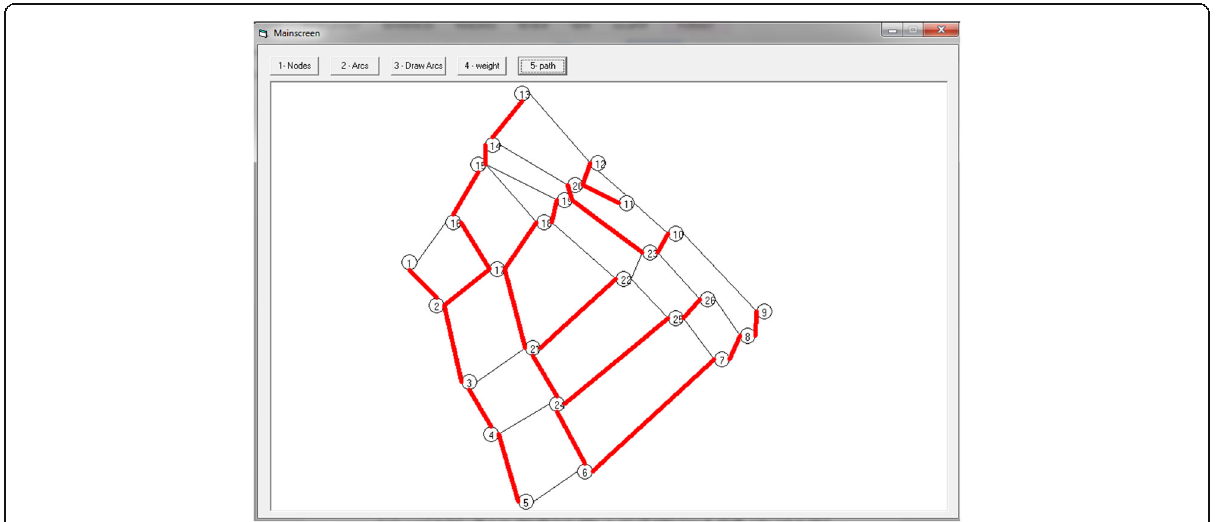
Fig. 24 The Results Derived from Implementing the Model of Volume of the Population on the Road Index on the Sample Data using Software